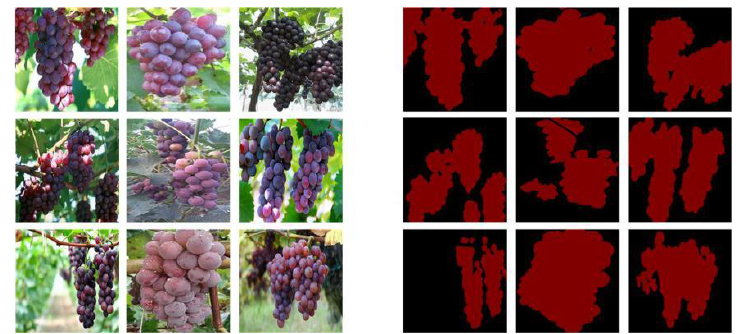
Figure 6. Annotated images and original images in the dataset.